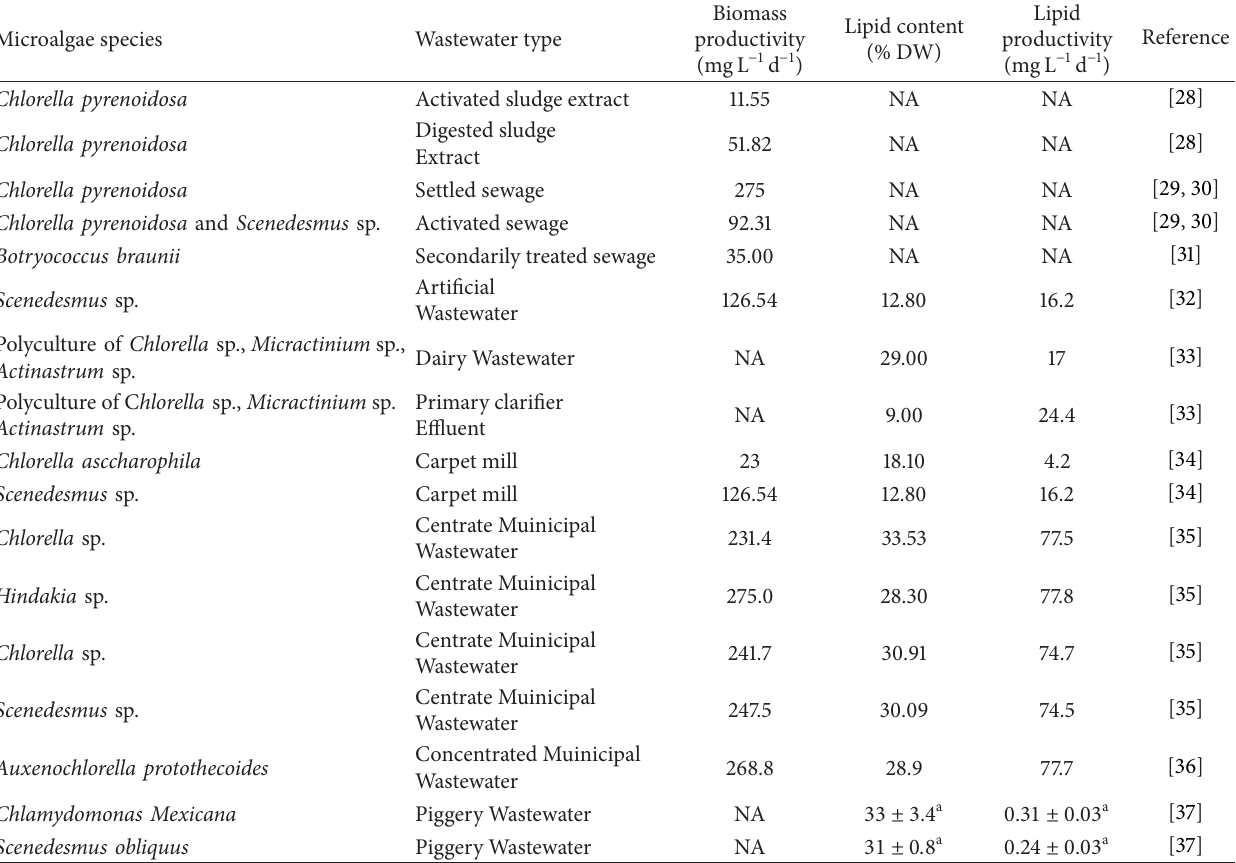
Table 1: Biomass and lipid productivities of microalgae grown in different wastewater